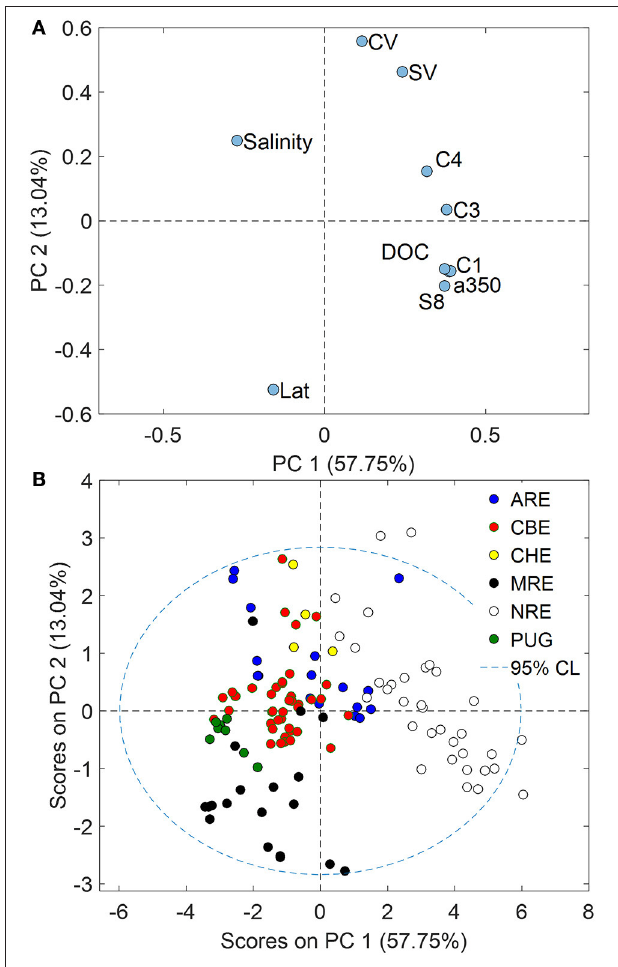
FIGURE 7 | (A) Loadings plot for variables and (B) scores plots for samples resulting from a PCA of the optical and chemical data for the six estuaries studied. PC1 likely represented discharge while PC2 was linked to